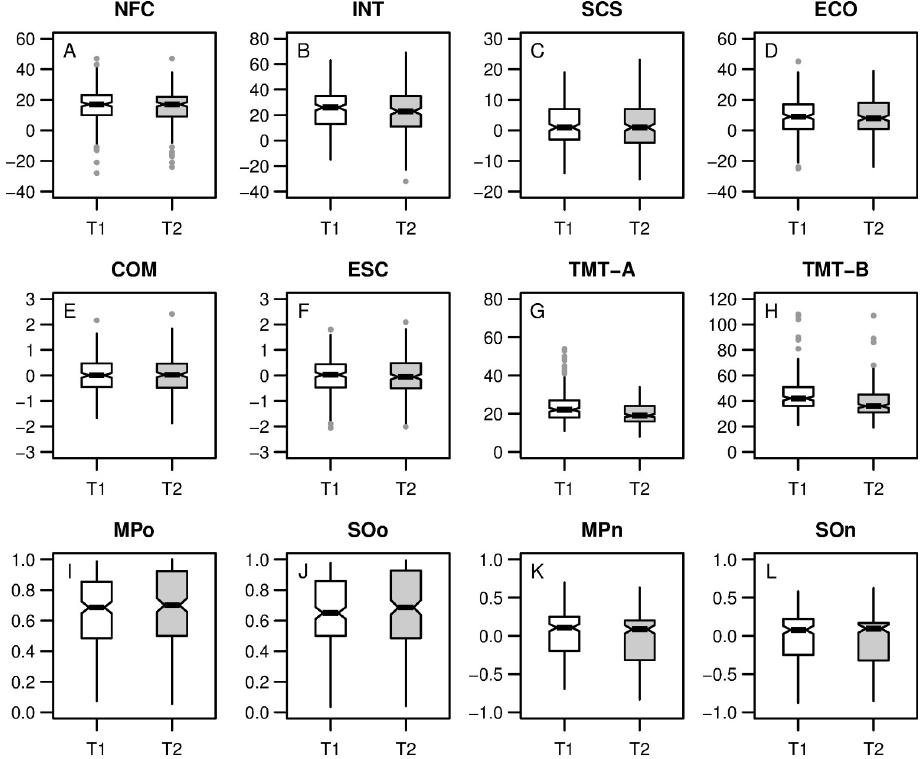
Fig 1. Boxplots of the variables in the study. (A-D) raw personality scale scores, NFC = Need for Cognition, INT = Trait Intellect, SCS = Self-Control Scale, ECO = Effortful Control; (E-F) factor scores of COM = Cognitive Motivation and ESC = Effortful Self-Control as derived from confirmatory factor analysis; (G-H) TMT-A/B = Trail- Making Test A and B scores; (I-L) proportion of low demand choices in the two demand selection tasks MP = Magnitude/Parity evaluation and SO = Sound/Orthography evaluation, for o = original and n = new measure.